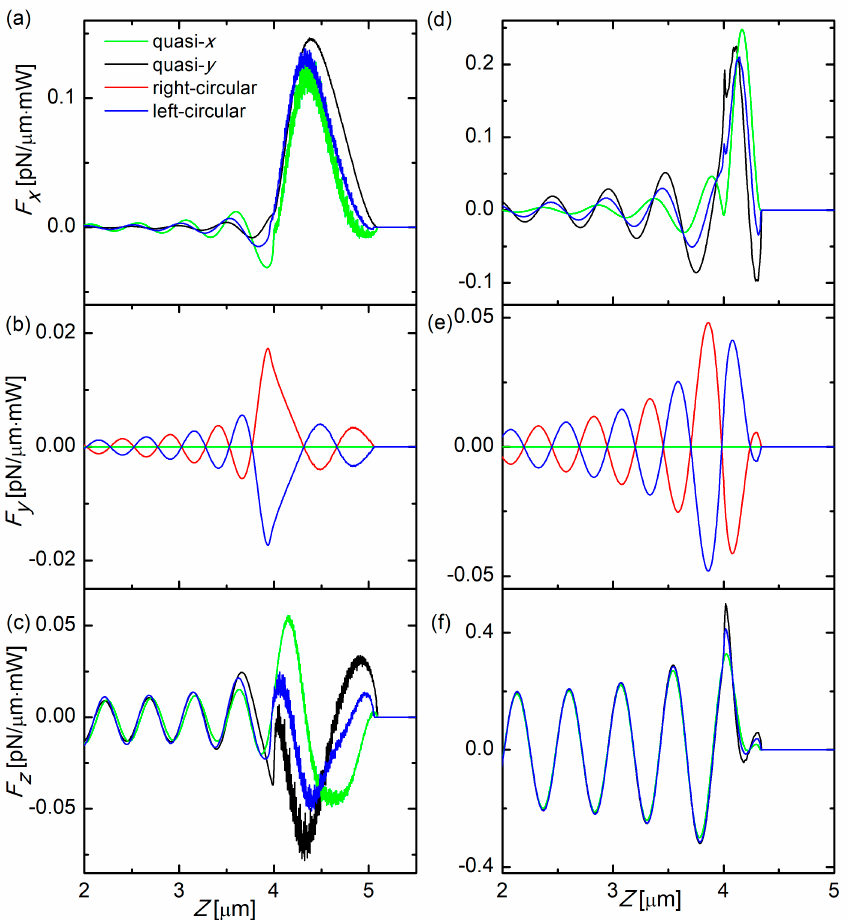
Figure 2. Calculated optical force components (integrated over transverse cross sections) are shown as a function of z upon quasi-linear and circular polarized excitations, ( a ) F x , ( b ) F y , ( c ) F z , for an oblique ( θ = 20 ◦ ) endface; and ( d ) F x , ( e ) F y , ( f ) F z , for an oblique ( θ = 50 ◦ ) endface. The labels in ( a ) apply to all other figures.